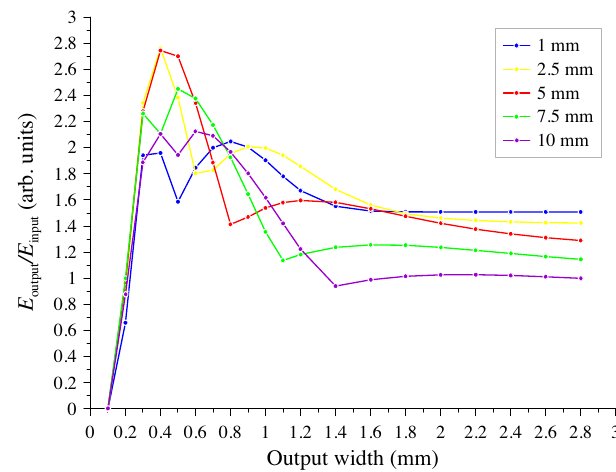
FIG. 8. Field enhancement at the focus of the tapered wave- guide as a function of the width d and length L